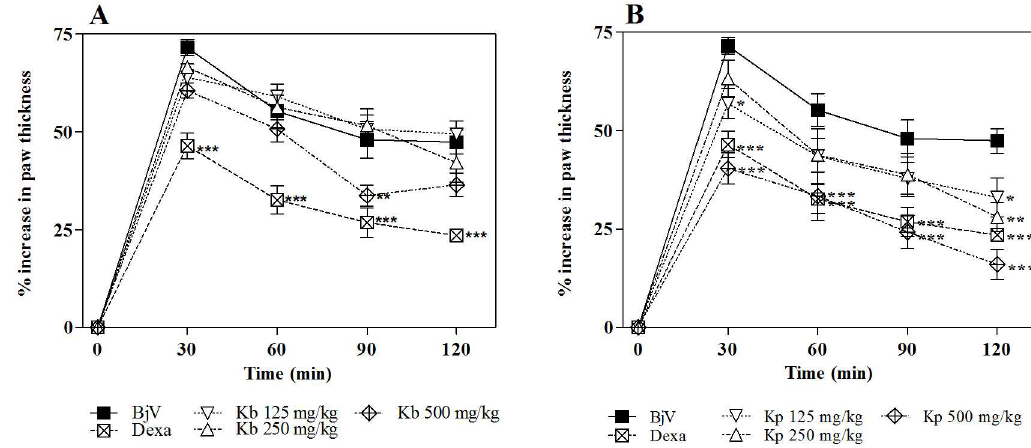
Fig 4. Inhibition of the hemorrhagic activity of B . jararaca (BjV) venom by extractsof K . brasiliensis (Kb) (A) and K . pinnata (Kp) (B) in post-treatment protocol. BjV was injected s.c. in the ventral regionof 5 mice before treatement with extract (500 mg/kg, i.p.). Three hours after venom injection, the skin was removed and weighed.The columns represent the mean ± SEM (n = 5). *** p < 0.001comparedto venom alone (one-way ANOVA followedby the Tukey’s